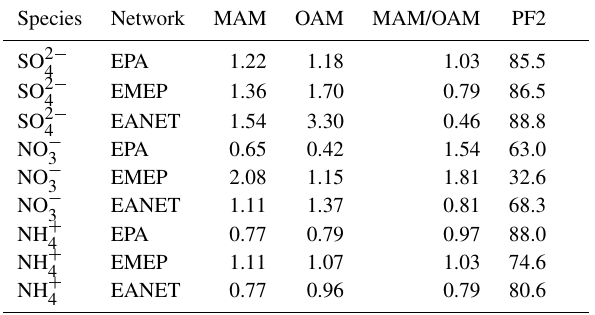
Table 2. Summary of the comparison of model data to the observa- tions of aerosol component concentrations. OAM and MAM are the spatial arithmetic mean of the observations and the model, respec- tively (in µgm − 3 ). PF2 is the percentage of model results within a factor of 2 in the observations. Figure 4. Simulated mean concentrations of PM